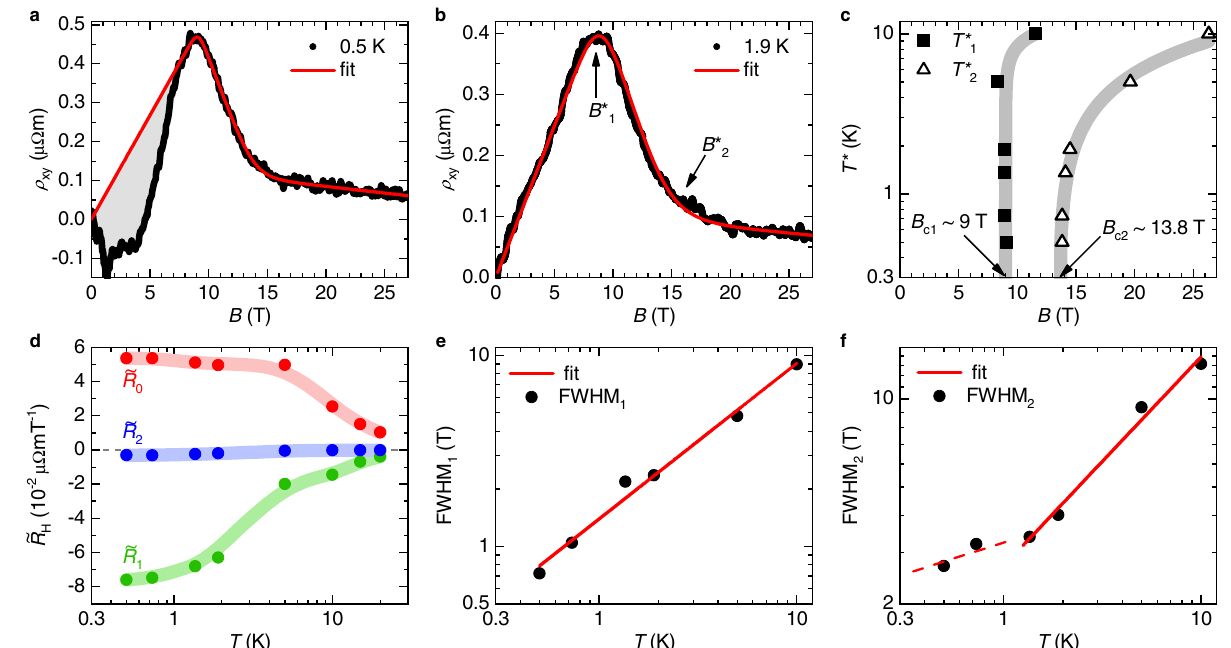
Fig.2| Two-stageFermisurfacereconstructioninCe 3 Bi 4 Pd 3 .a Hallresistivityvs applied magnetic fi eld at 0.5K, together with the best fi t according to the two- crossoversmodel(seeSupplementaryNote7).Thedeviationofthedatafromlinear behavior (shaded grey area) is due to a Berry curvature-derived anomalous Hall contribution (Ref.11). b Same as (a) at 1.9K. The Berry-curvature derived con- tribution is essentially absent at this temperature. The two characteristic fi elds B * 1 and B * 2 mark the positions of the crossovers between the different regimes. c The crossover fi elds B * 1 ð T Þ and B * 2 ð T Þ determinedfromthe ρ xy ( B ) fi tsareplottedas T * 1 ð B Þ and T * 2 ð B Þ , respectively, in a temperature-magnetic fi eld phase diagram. They extrapolate,inthezero-temperaturelimit,to B c1 and B c2 andseparatethreeregimes